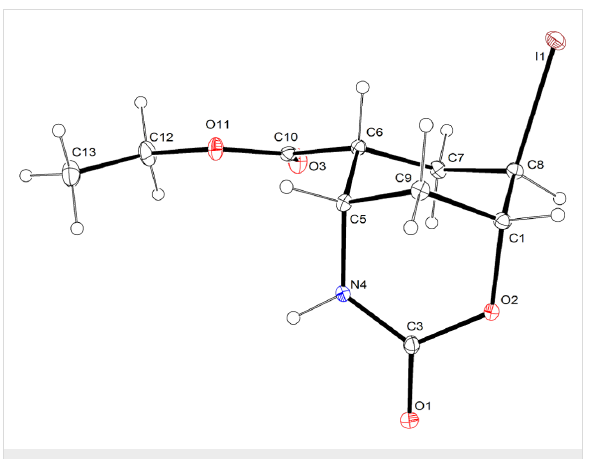
Figure 1: ORTEP diagram of iodooxazinone 2. Thermal ellipsoids have been drawn at the 20 % probability